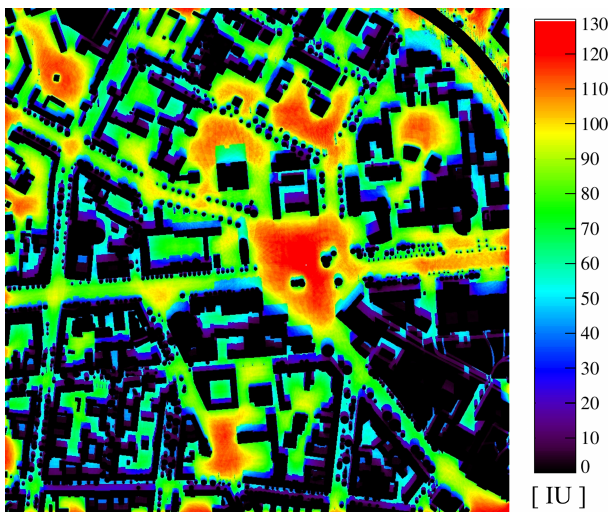
Figure 6. Vitamin D weighted exposure in IU per minute of a human on 21 June at noon in Berlin (Ernst-Reuter-Platz) under cloudless conditions. The human wears a T-shirt and pants and is oriented towards the south. Approximately 1000 IU per day are recommended as an adequate vitamin D status. Background: building height data created by DLR based on CityGML data from FIS Broker Berlin (https://www.stadtentwicklung.berlin.de/ geoinformation/fis-broker/, last access: 18 February